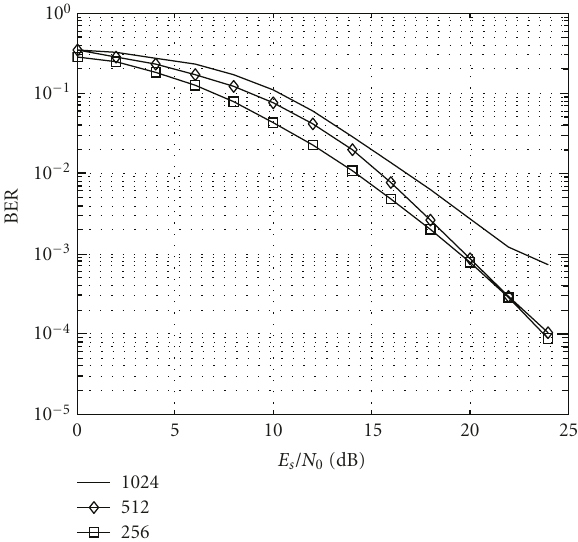
Figure 8: BER for di ff erent packet sizes,